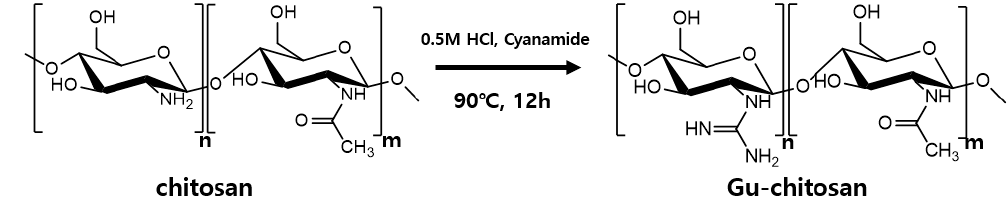
Figure 2. Reaction scheme of the chitosan guanidinylation.